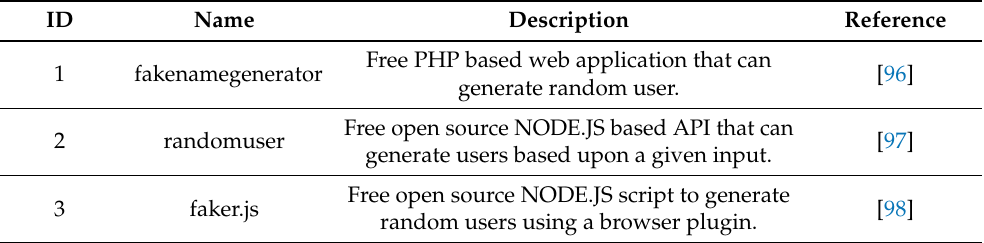
Table 23. Tools used for fake persona